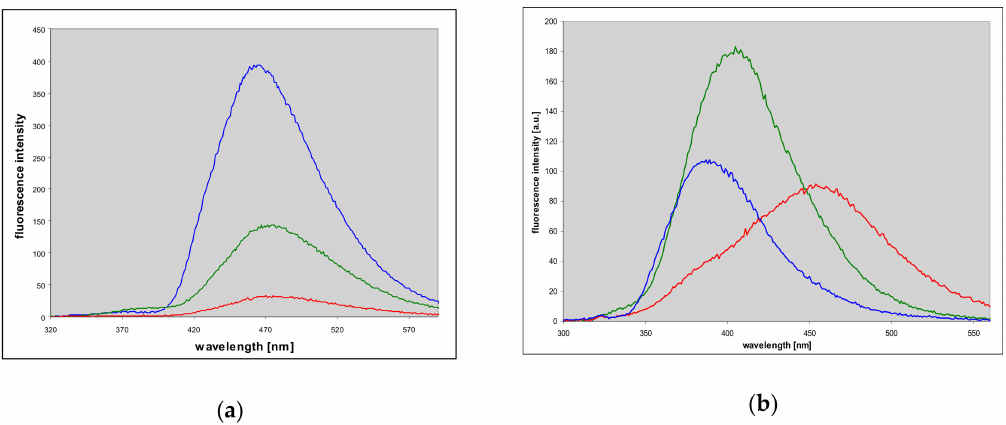
Figure 4. Fluorescence spectra of ( a ) 1,N 2 -etheno-2-aminopurine ( 1 ) and ( b ) N 2 ,3-etheno-2-aminopurine ( 2 ) in aqueous medium at various pH: red curves, pH 3; green, pH 6.5 ( a ) and 7 ( b ); blue—pH 11.5. Excitation was at 300 nm ( a ) and 290 nm ( b ).